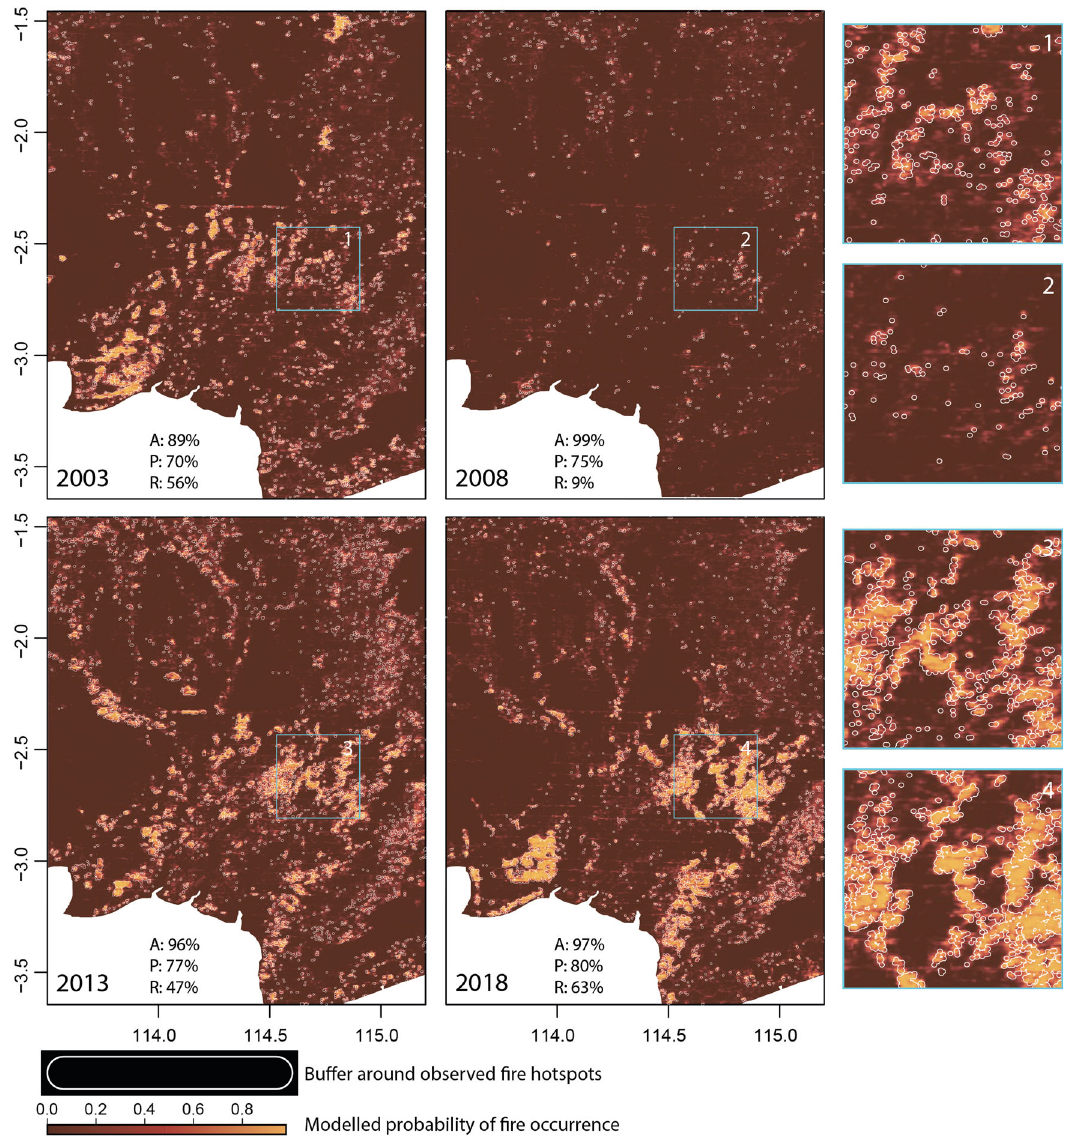
Fig. 3 FireCNN model outputs. FireCNN model outputs showing the estimated distribution of probability of fi re (0 – 1) for years 2003, 2008, 2013, and 2018 against observations of MODIS and VIIRS hotspot data outlined in white. Close up areas 1 – 4 are displayed next to the full size maps. Accuracy (A), precision (P), and recall (R) for each year are marked as annotations. Accuracy is the percentage of all model estimates that are correct ( fi re and not- fi re), precision is the percentage of model fi re estimates that are correct, and recall is the percentage of observed fi re hotspots that the model correctly